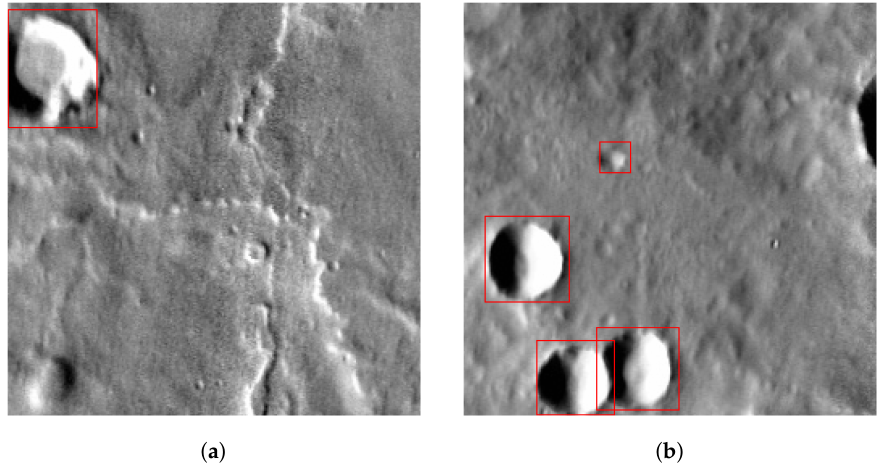
Figure 1. Examples of the training images and labels: ( a ) Single crater; ( b ) Multiple